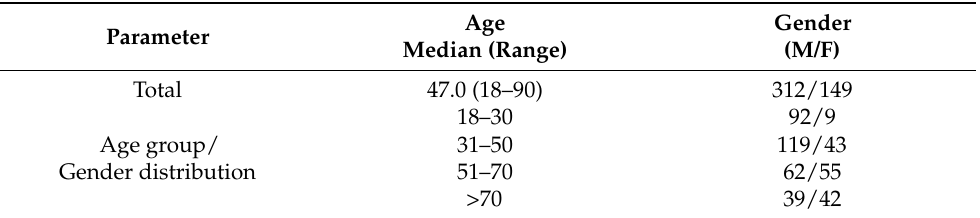
Table 2. General information of the 461 retrospectively analysed cases of isolated unilateral zygomatico-orbital fractures included in the